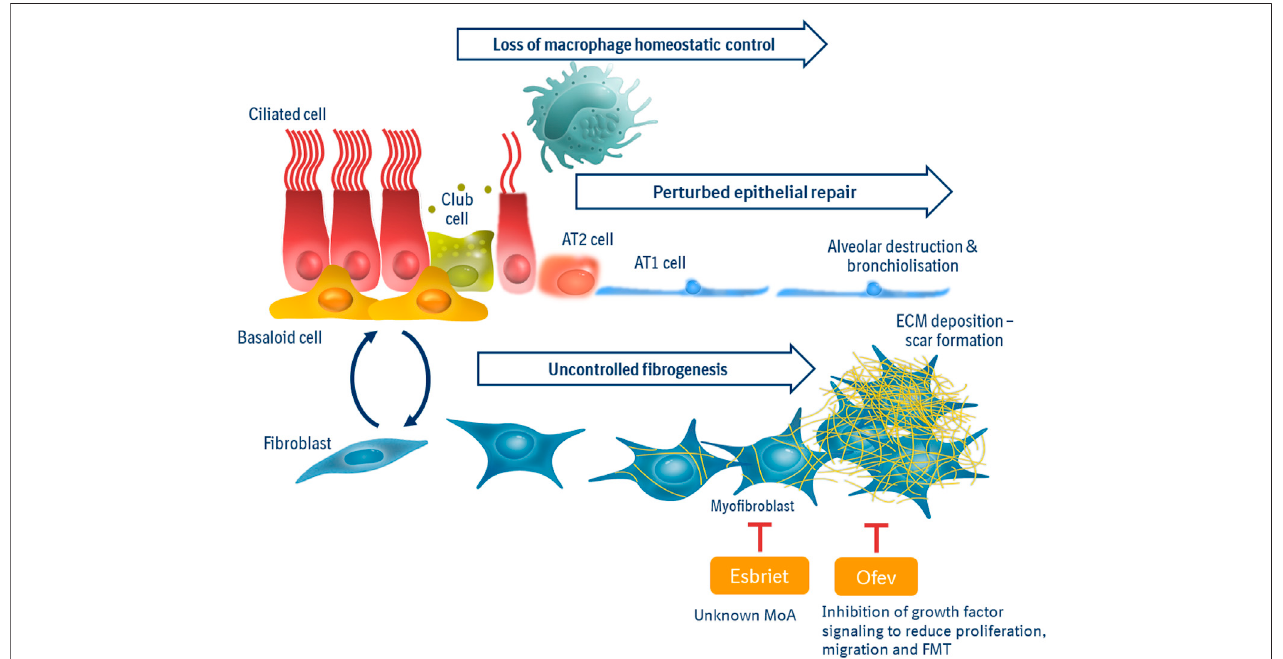
FIGURE 1 | Master Mechanisms of the immuno fi brotic niche. Pathologic drivers in pulmonary fi brosis can be viewed as three “ master mechanisms ” : Uncontrolled fi brogenesis,drivenbypro- fi broticgrowthfactorsandtissuestiffness,isthecurrentpointofinterventionforstandardsofcare “ anti- fi brotics. ” Perturbedepithelialrepairis due to dysregulated/transitional small airway and/or alveolar progenitor populations, leading to senescence, impaired barrier function and poor gas exchange. Loss of macrophage homeostatic control is characterized by an imbalance of pro- fi brotic vs. pro-repair macrophage phenotypes to resulting in less efferocytosis and heighted in fl ammation within the lung. The immuno fi brotic niche is interconnected, where macrophage activity and phenotype can be in fl uenced by senescent fi broblasts; aberrant signals from epithelium promote fi brosis and scar-forming fi broblasts hinder effective epithelial repair.